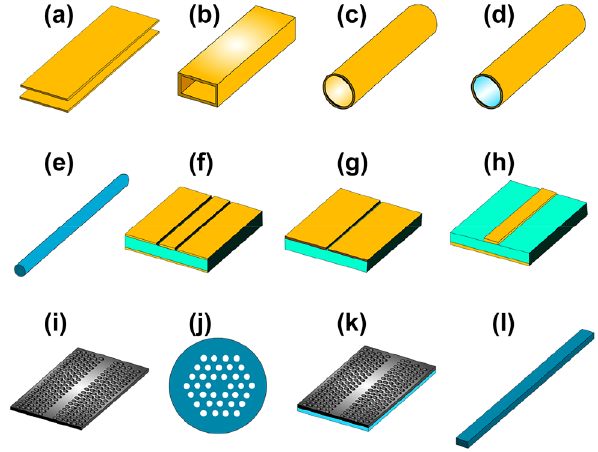
Figure 1: Low-loss waveguides for the THz range, (a) parallel plates waveguide, (b) metallic rectangular waveguide, (c) metallic circular waveguide, (d) circular waveguide with dielectric coating, (e) polymer fi ber, (f) coplanar showing substrate in aquamarine color, (g) slot line, (h) stripline, (i) photonic crystal waveguide, (j) photonic crystal fi ber, (k) SIIG with dielectric substrate, (l) ribbon waveguide. The colors gray, yellow, and blue represent silicon, metal, low-index dielectric material, respectively.